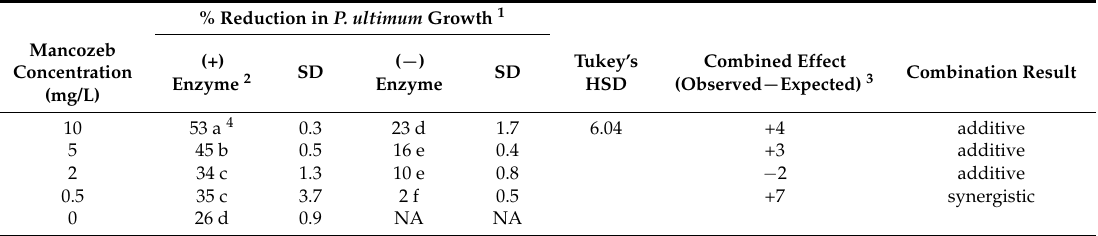
Table 7. Inhibition of Pythium ultimum and Fusarium graminearum by the stabilized LPO formulation alone and in combination with mancozeb using fungicide-amended